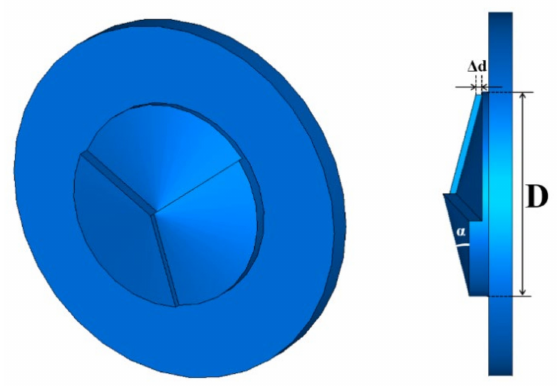
Figure 6. Three-stepped axicon